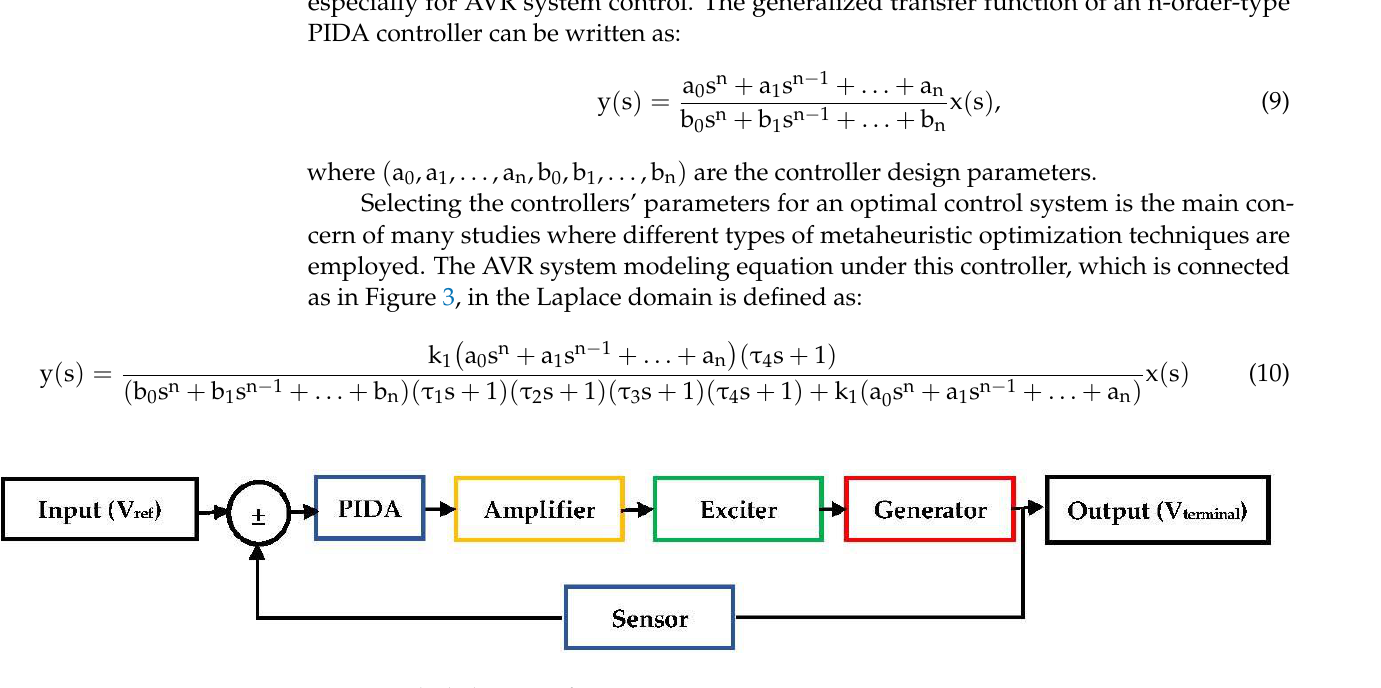
Figure 3. Block diagram of PIDA-AVR system.